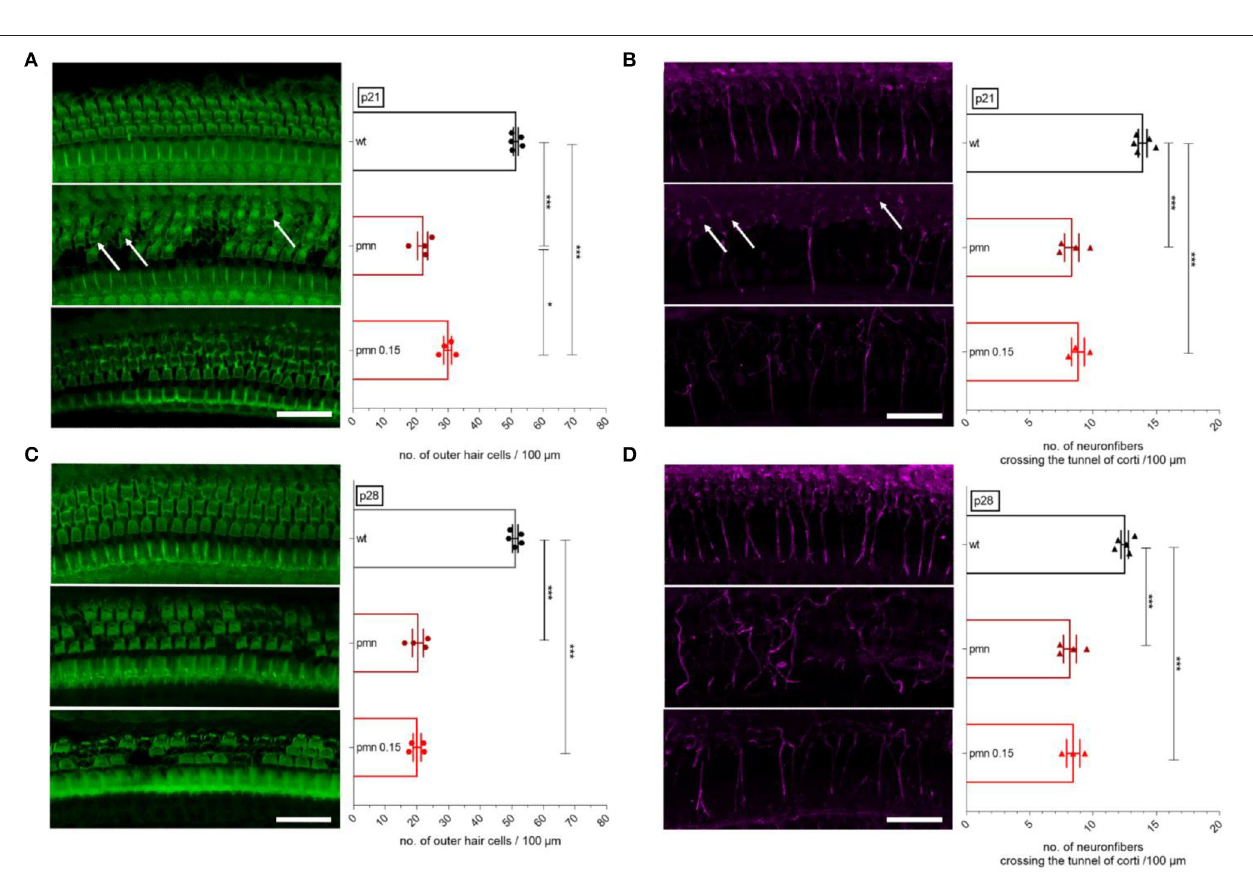
FIGURE 2 | Whole-mount staining and evaluation of the organ of Corti. Examples of immunostaining show the OHCs (green, F-actin) and neuronal fibers crossing the tunnel of Corti (magenta, ßIII-tubulin). (A) At p21, the number of OHCs was significantly reduced in PMN animals ( p < 0.001). Interestingly, peg-IGF-1 has a positive effect on the OHCs compared to the untreated PMN littermates ( p < 0.05). (B) At the same age, neuronal fibers in the tunnel of Corti were significantly reduced in all PMN groups ( p < 0.001). Here, peg-IGF-1 showed no effect. Although the neural fibers were reduced, synapses and OHCs were still present (white arrow). (C) At P28, treated and untreated PMN animals had the same decreased amount of OHCs ( p < 0.001). (D) Regarding neuronal fibers, all PMN mice had fewer neuronal fibers ( p < 0.001). Ordinary one-way ANOVA with multiple comparison tests and the post hoc Tukey analysis. Scale bar: 20 µ m. Significances: * p < 0.05, *** p <